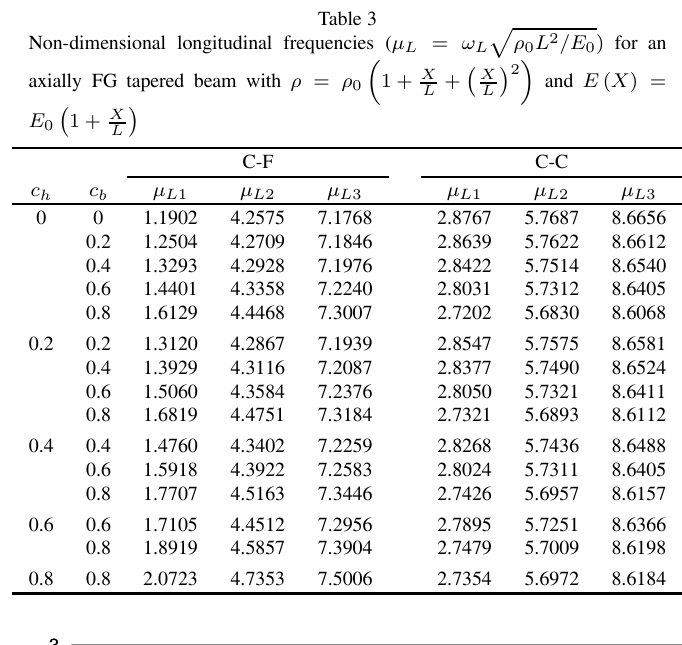
Non-dimensional longitudinal frequencies ( μ L = ω L axially FG tapered beam with ρ = ρ 0